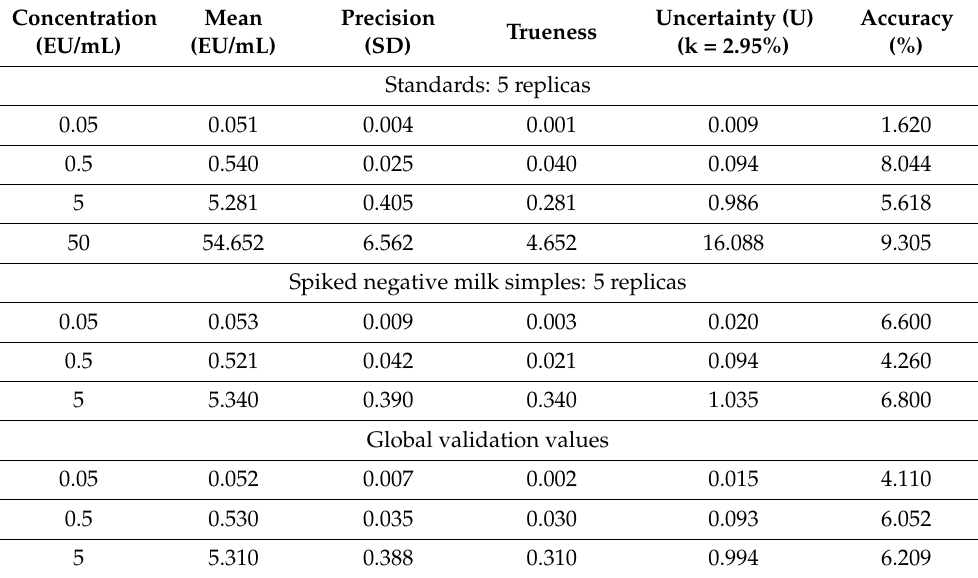
Table 2. Validation of the kinetic turbidimetric Limulus amebocyte lysate (LAL) assay for endotoxin quantification in milk samples using endotoxin standards and spiked milk samples: precision, trueness, and